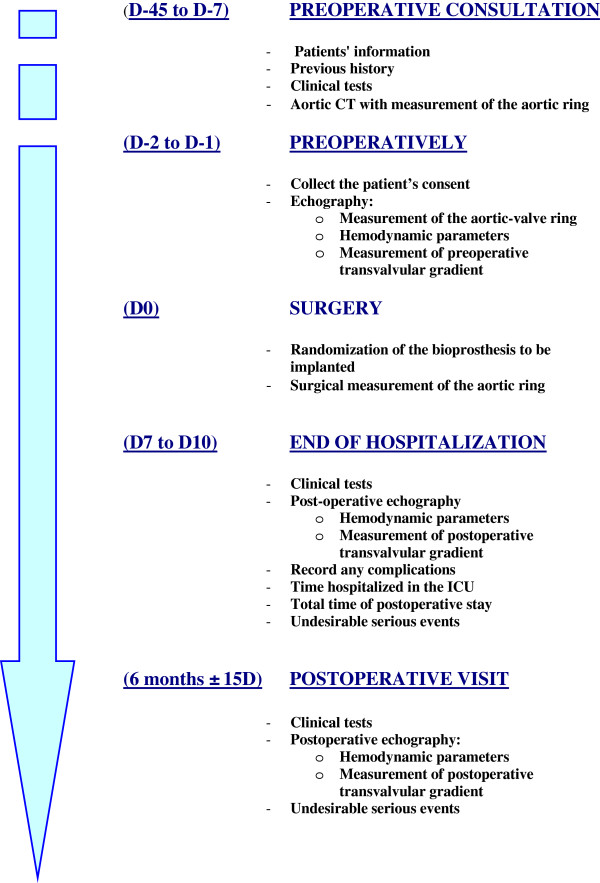
Study’s flowchart.